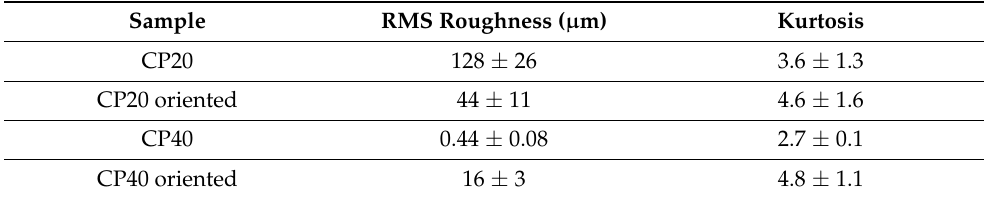
Table 1. RMS roughness and kurtosis from AFM images for CP20 and CP40 samples.